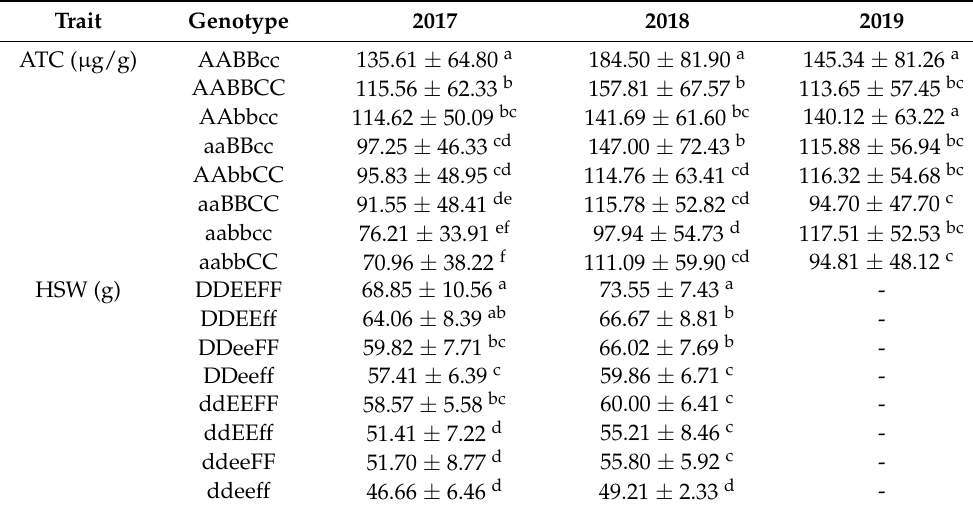
Table 6. Phenotypic effect of major QTLs for ATC ( qAFTA05.1 , qAFTB06.3 and qAFTB05.2 ) and HSW ( qHSWA05 , qHSWA08 and qHSWB06 ) in the RIL